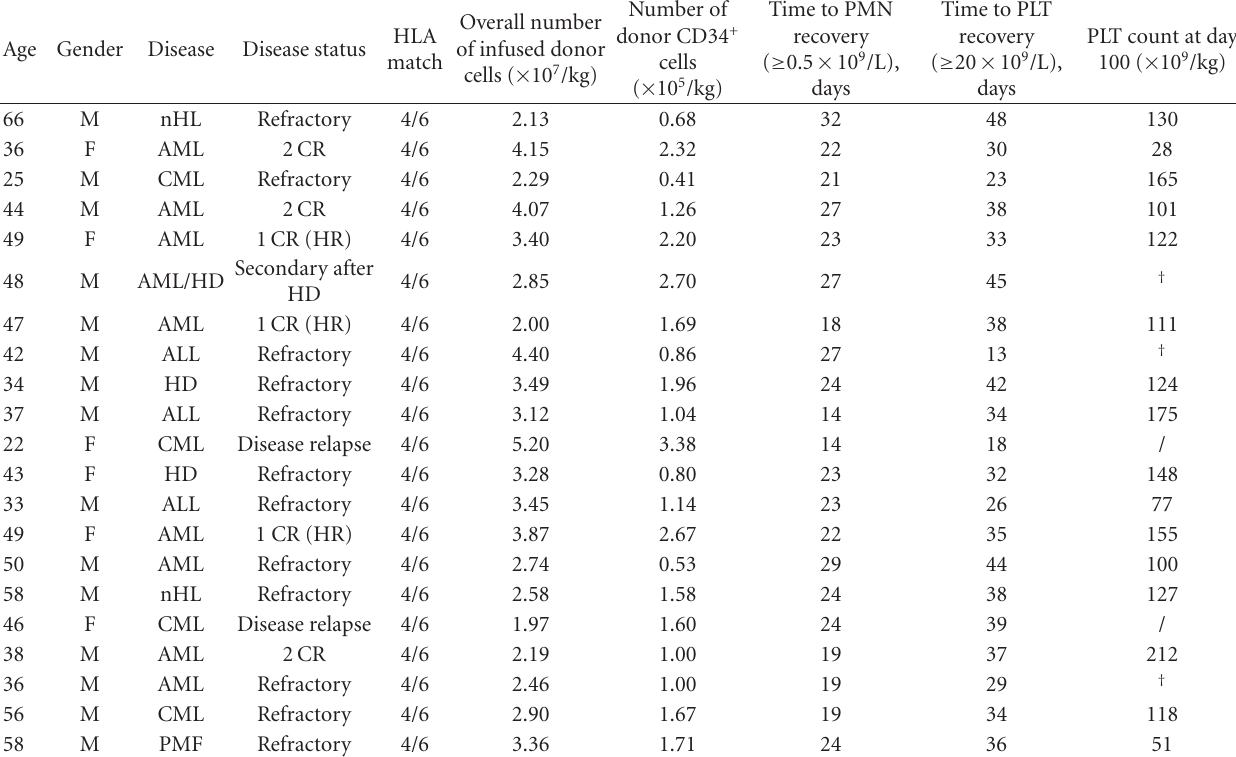
Table 1: Main patients’